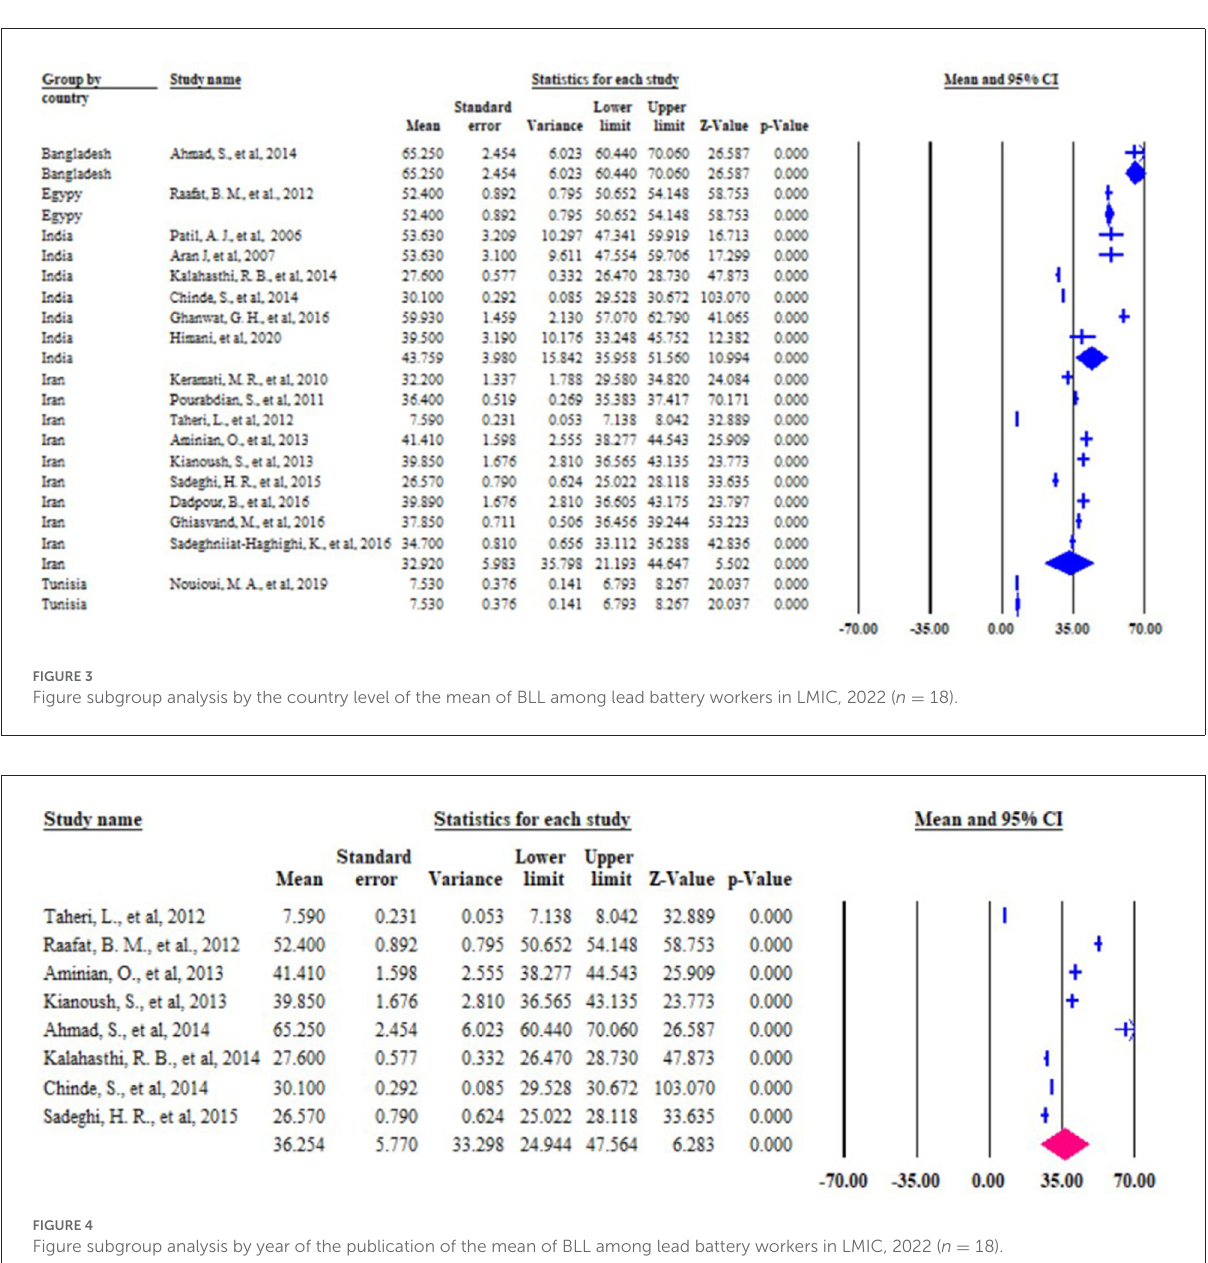
study effects. Therefore, for medium study size and continuous outcome variables, Begg’s test is recommended. So for estimating the mean blood lead level among lead battery factory workers in Low and Middle-Income countries were [( p = 0.0053) and ( p = 0.47) for Egger’s test and Begg’s test respectively] (Figure